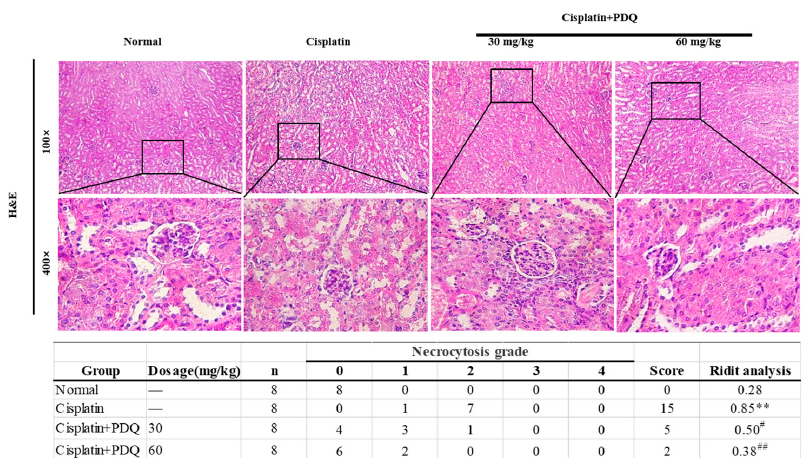
Figure 2. Histological examination of morphological changes in kidney tissues. Renal tissues were stained with hematoxylin and eosin (H&E) (100×, 400×), and the necrocytosis grade was assessed by ridit analysis. n = 8, ** p < 0.01 vs. normal group; # p < 0.05, ## p < 0.01 vs. cisplatin group.